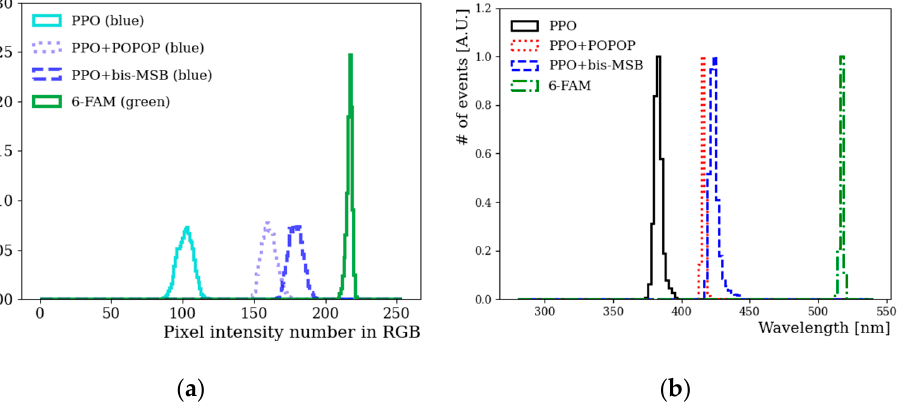
Figure 8. ( a ) Blue components were extracted from the photographed images of PPO, PPO+POPOP and PPO+bis-MSB. In addition, a green component of 6-FAM was shown. The spectrum of blue or green component in the RGB color space was drawn as a function of color intensity value with 256 scale. The smaller a pixel intensity value, the closer it is to black. ( b ) The extracted emission spectra of PPO, POPOP, bis-MSB, and green dye, based on H–W relation. The separation between PPO, POPOP, bis-MSB, and green dye samples can be clearly seen with a reasonable